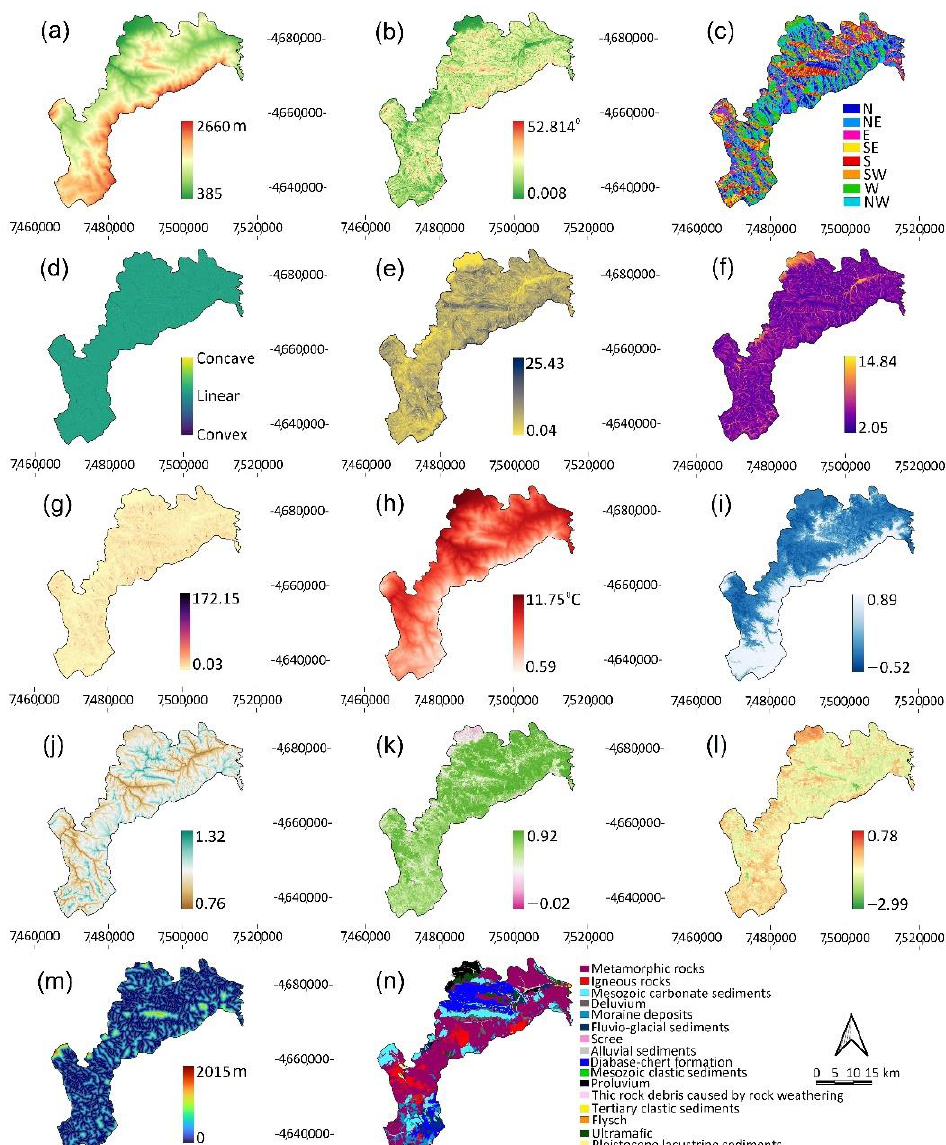
Figure 3. Suitability maps of the Šar Mountains—main physical characteristics. ( a ) Elevation; ( b ) slope; ( c ) aspect; ( d ) profile curvature; ( e ) TRI; ( f ) TWI; ( g ) LS factor; ( h ) Air temperature; ( i ) NDSI; ( j ) WEI; ( k ) NDVI; ( l ) BSI; ( m ) distance from stream; and ( n ) lithology.